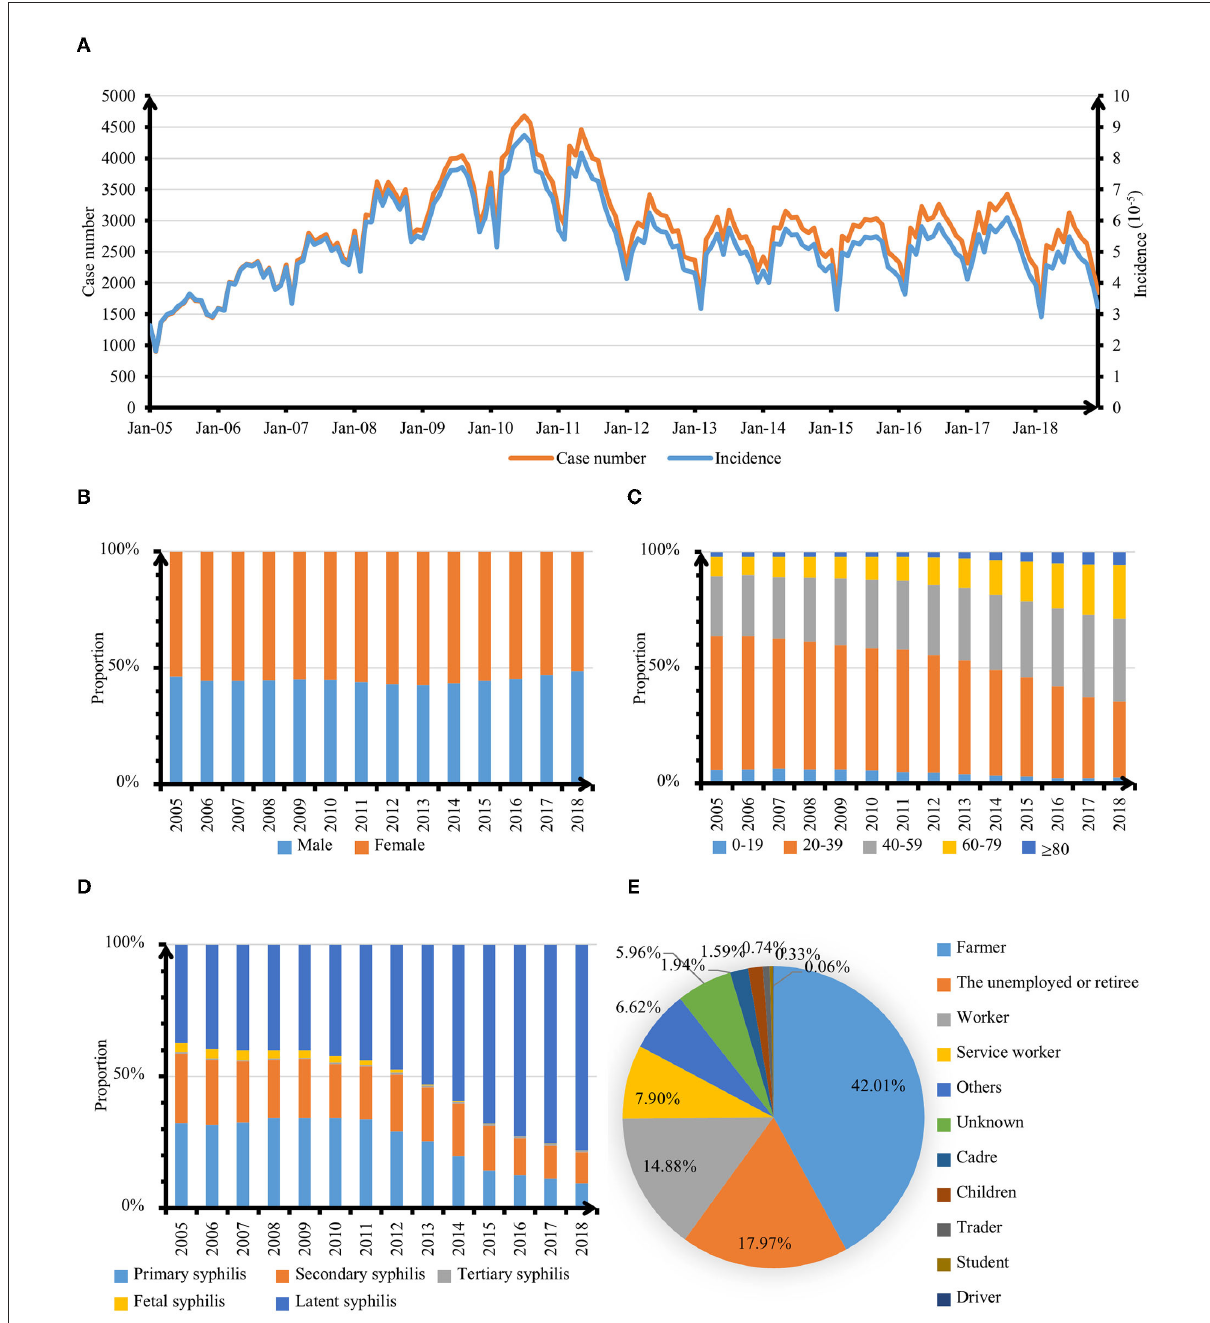
FIGURE1 Epidemiological features of syphilis cases in Zhejiang Province, 2005–2018. (A) Monthly distribution of reported cases and incidence of syphilis. (B) Sex distribution of syphilis cases. (C) Age distribution of syphilis cases. (D) Clinical type distribution of syphilis cases. (E) Occupation type distribution of syphilis